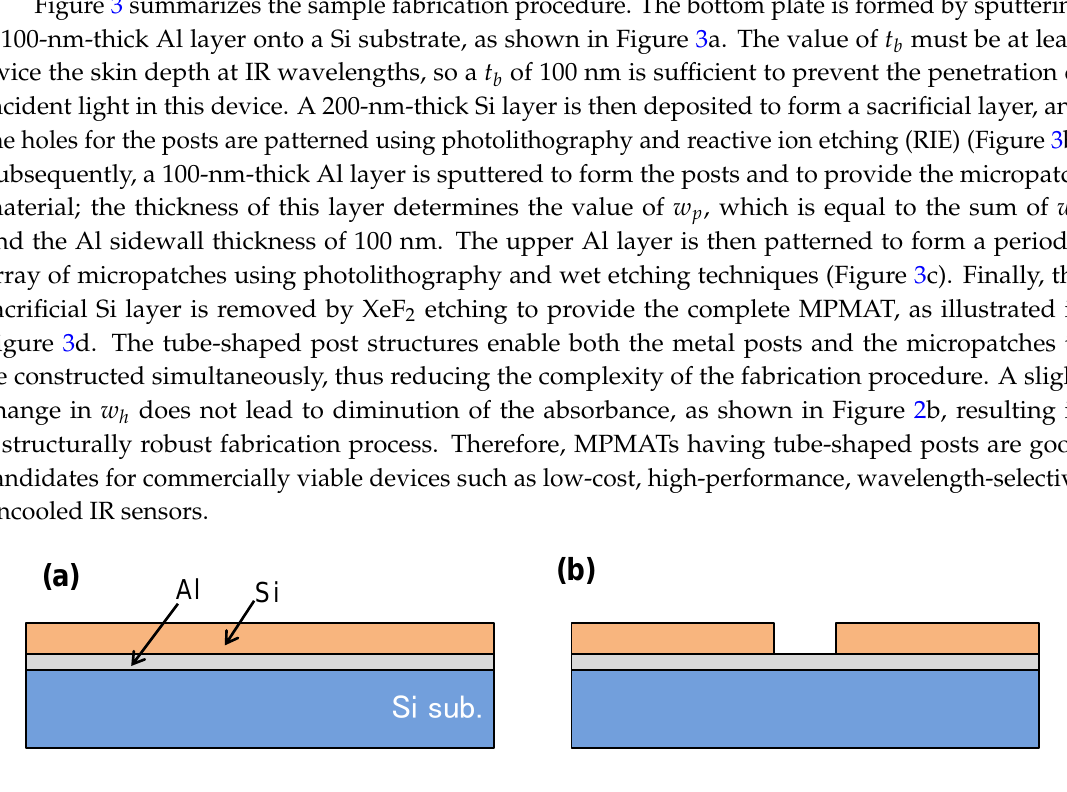
Figure 4. SEM images of an MPMAT: ( a ) top; ( b ) oblique and ( c ) magnified cross-sectional views of the periodic structures.